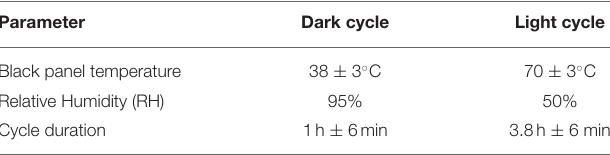
TABLE 1 | Accelerated weathering parameters based on SAE